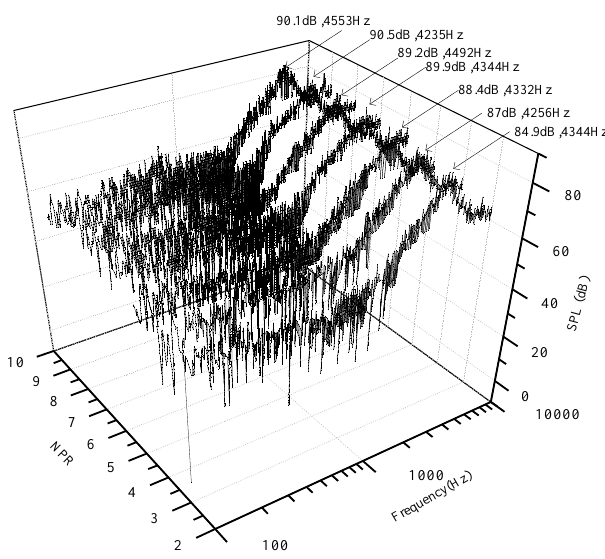
Figure 9. Acoustic spectrograms of HRT at L = 4 D j for NPR ranging 3–9. Table 2. The frequency and SPL data for cases at the corresponding nozzle pressure ratio (NPR). NPR